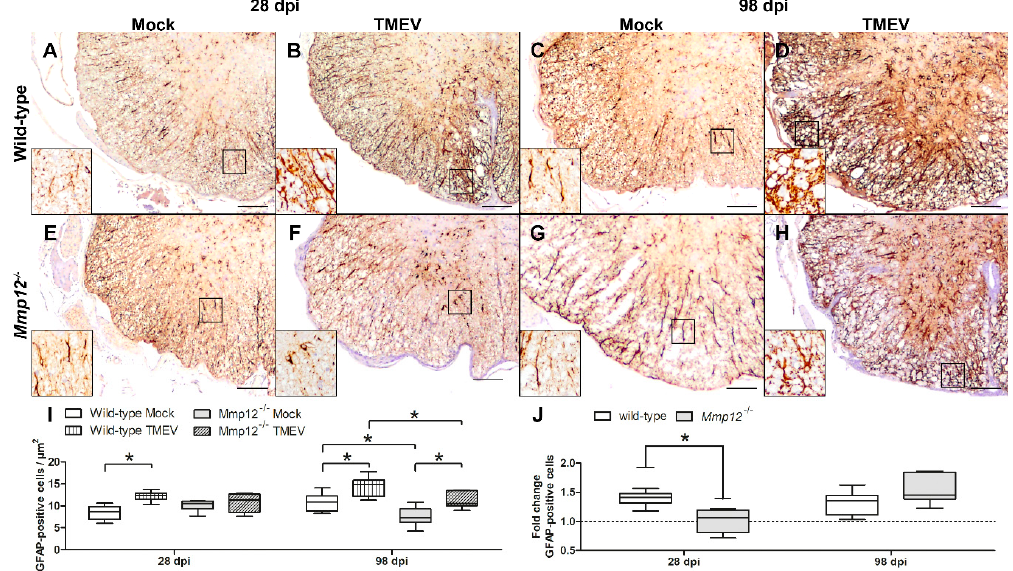
Figure 1. Quantification of astrogliosis by glial fibrillary acidic protein (GFAP) immunohistochemistry in the spinal cord of mock- and Theiler’s murine encephalomyelitis virus (TMEV)-infected wild-type and matrix metalloproteinase 12 knockout ( Mmp12 − / − ) mice at 28 and 98 days postinfection (dpi; A – H ) . Astrocytes show strong cytoplasmic GFAP expression in the gray and white matter. The inserts show higher magnification of the areas delineated by the black rectangles. The bars represent 100 µm in the overview pictures and 35 µm in the inserts. The density of GFAP-positive cells in TMEV-infected wild-type mice was increased at 28 and 98 dpi ( I ) while TMEV-infected Mmp12 − / − mice showed an increased density of GFAP-positive cells at 98 dpi only ( I ). Interestingly, TMEV-infected Mmp12 − / − mice exhibited a reduced density of GFAP-positive cells at 98 dpi compared with wild-type mice and a reduced fold change of GFAP-positive cells in the spinal cord at 28 dpi ( J ) indicating the significant impact of MMP12 on the onset and progression of astrogliosis. Data are shown as box plots with whiskers indicating minimum and maximum values—the lower boundary of the boxes representing the 25th percentile, the upper boundary the 75th; the horizontal line in the boxes represents the median value ( I , J ). Significant differences between the groups as detected by the Mann–Whitney U test are marked by bars and asterisks (* p < 0.05).